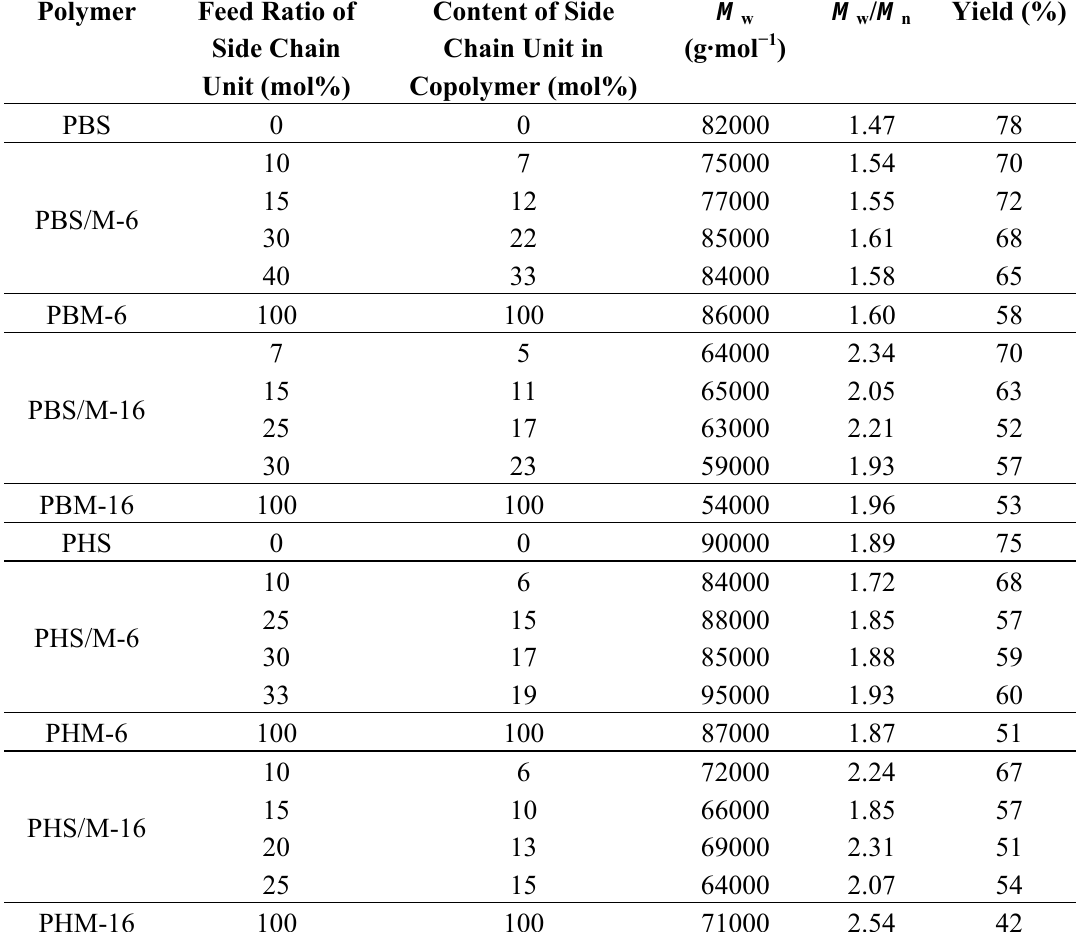
Table 2. M and M / M of polymers with various contents of the side chain w w n